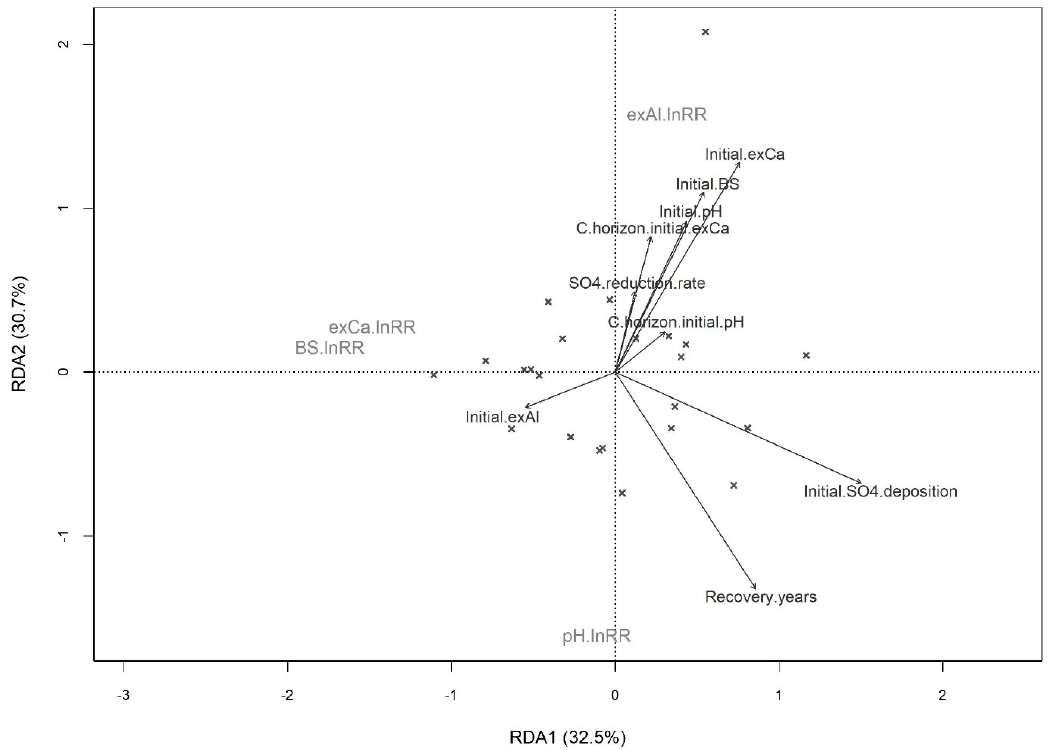
Figure 9. Redundancy analysis showing the relationship between soil recovery indices (light grey) and explanatory variables (black) for the B Horizon of 23 soil resampling sites in Eastern Canada and the Northeastern United States. Points (x) represent the soil resampling sites.